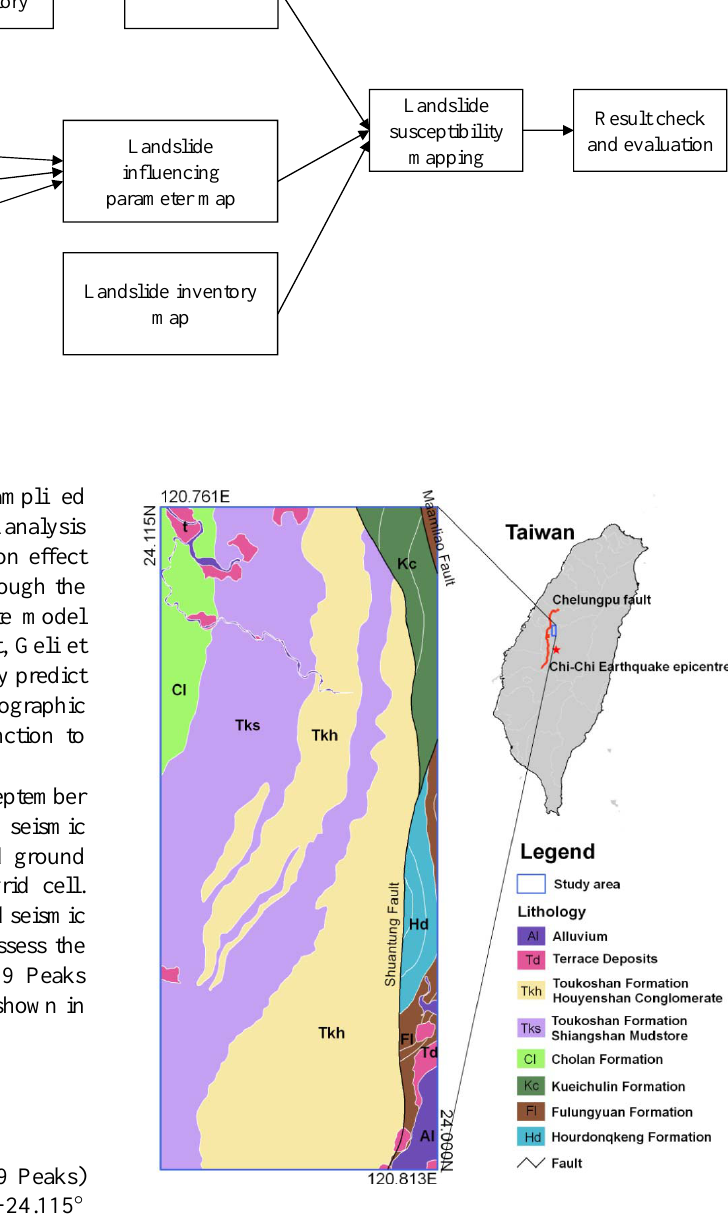
Fig. 2. Location and geological map of the study area.